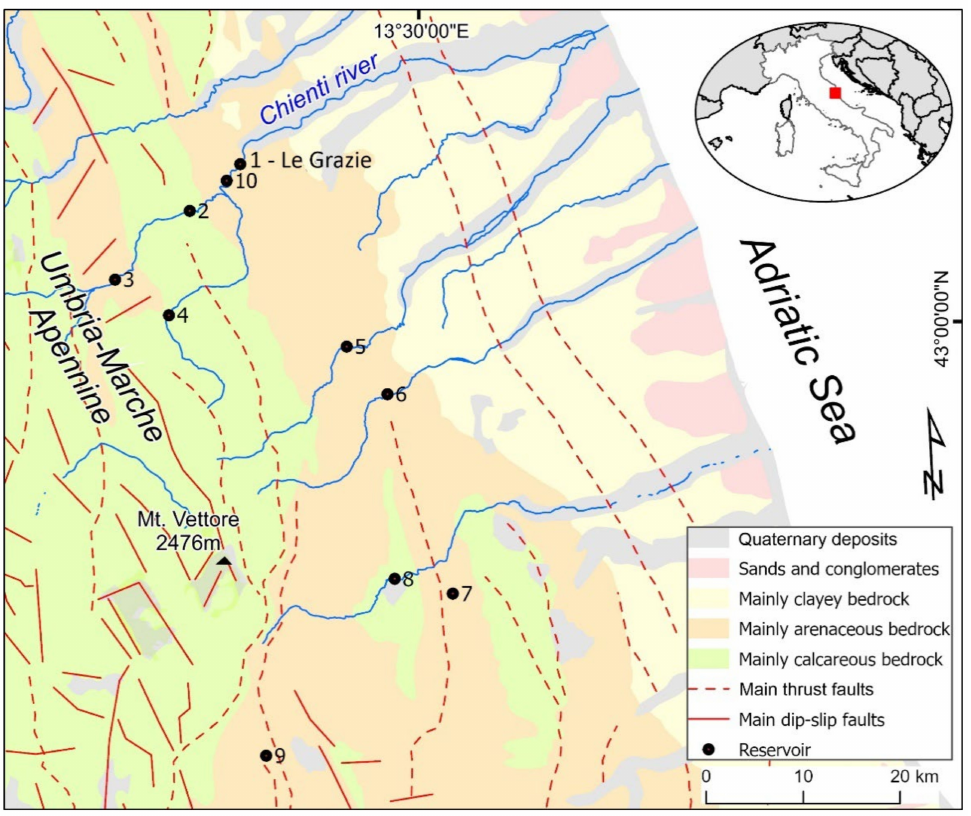
Figure 1. Geological sketch of the study area (numbers indicate the artificial reservoirs analyzed within the paper). (1) Le Grazie; (2) Borgiano; (3) Polverina; (4) Fiastrone; (5) San Ruffino; (6) Gerosa; (7) Villa Pera; (8) Talvacchia; (9) Colombara (10)